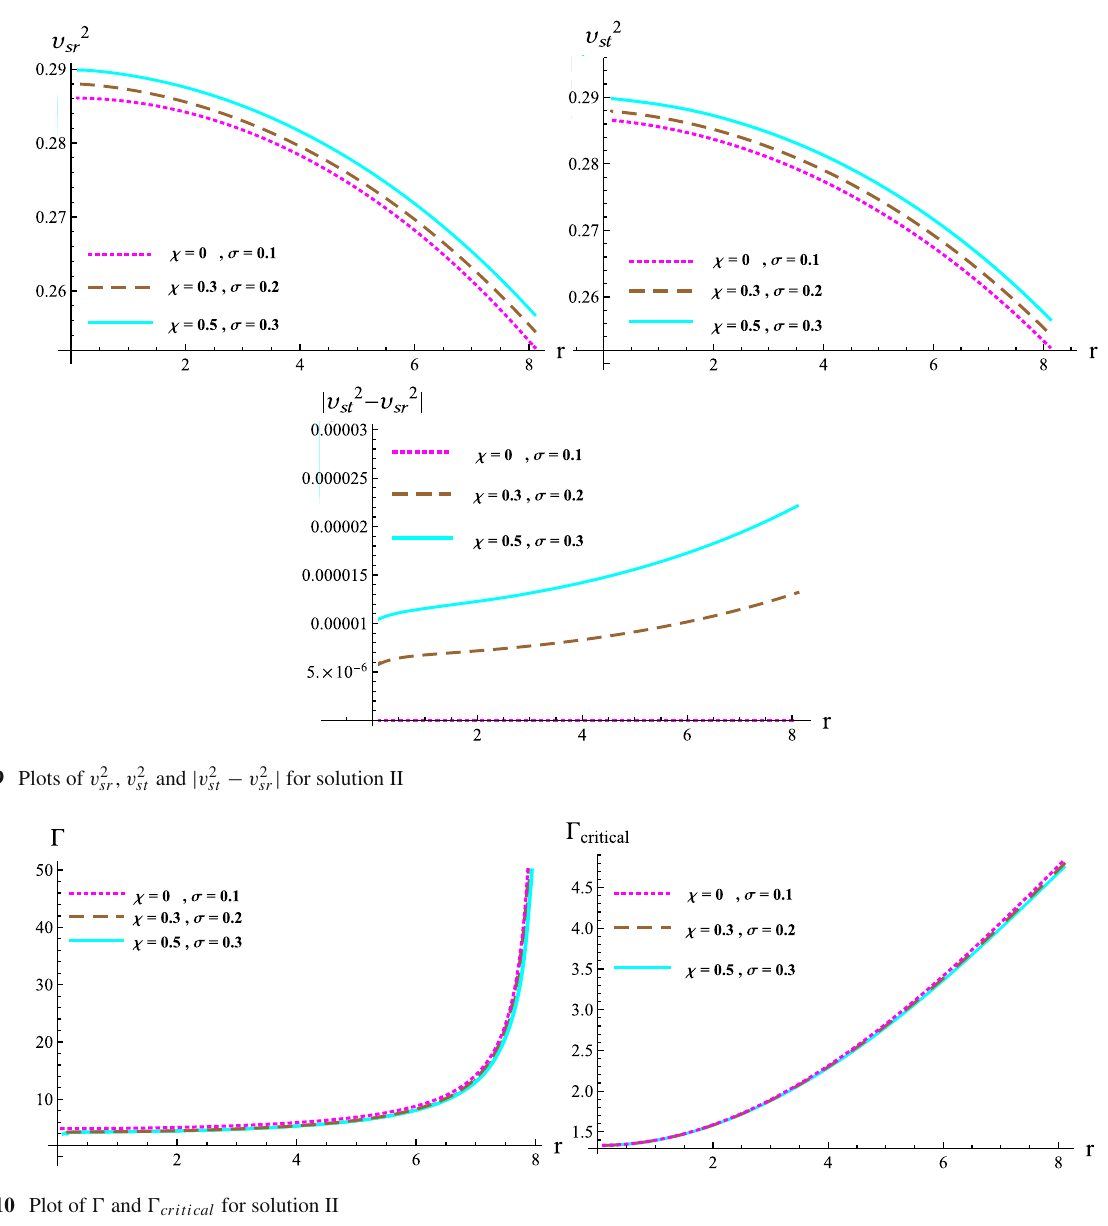
sistent with the inequality (cid:20) ≥ (cid:20) critical . Thus, the